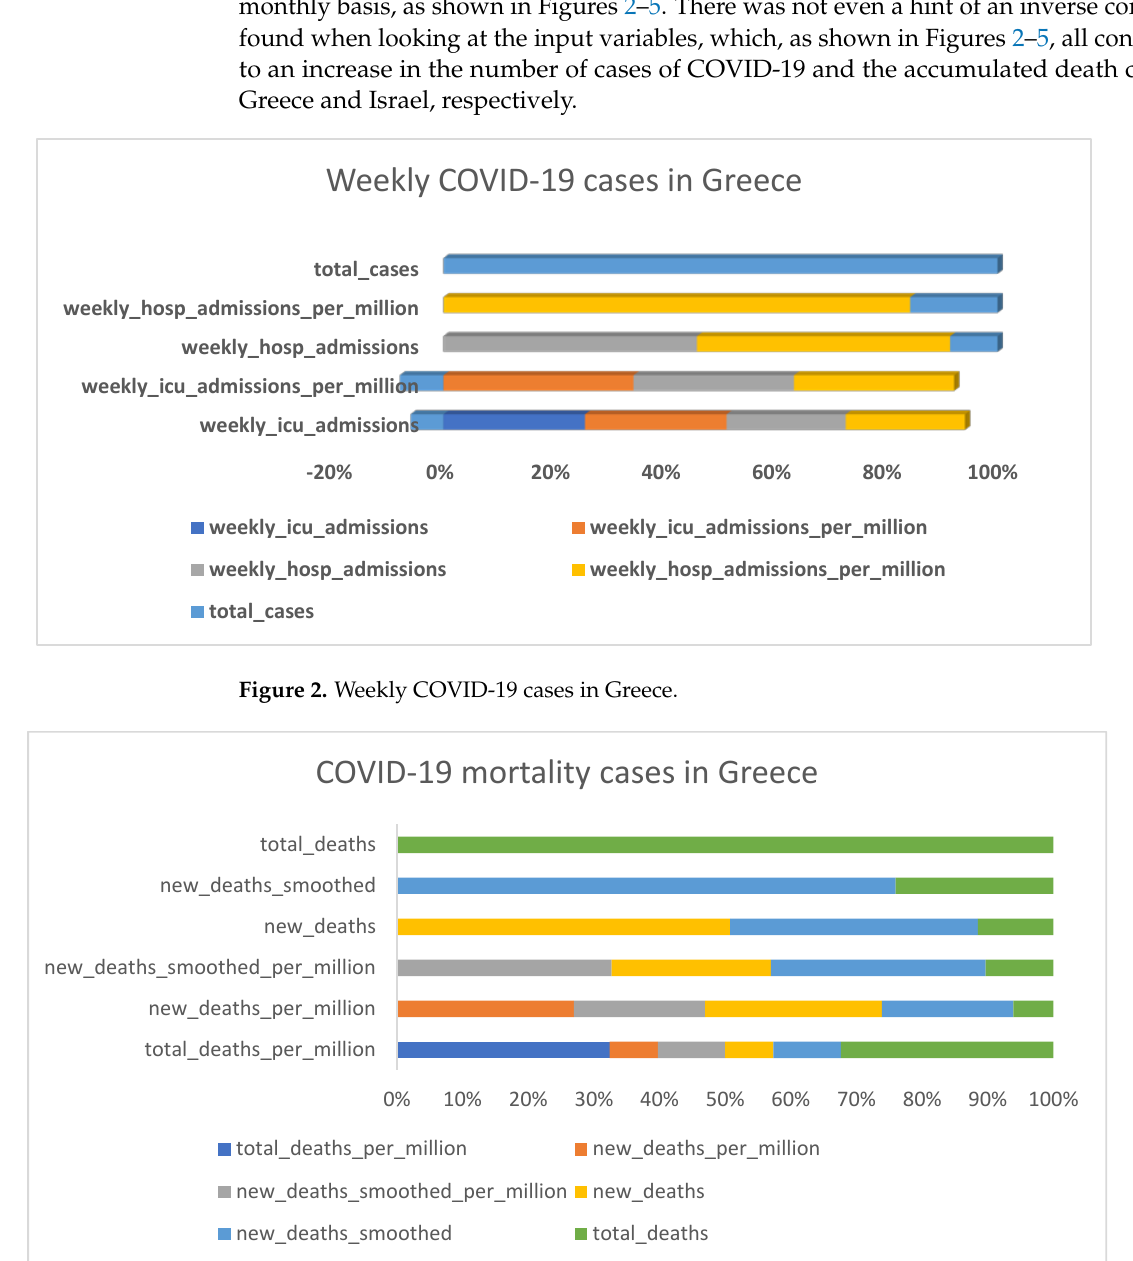
8 of 14 Table 1. Results of the Models.